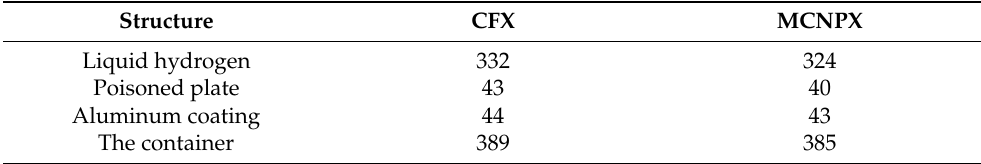
Table 1. Comparison of heat deposition calculation results between MCNPX and CFX (W).